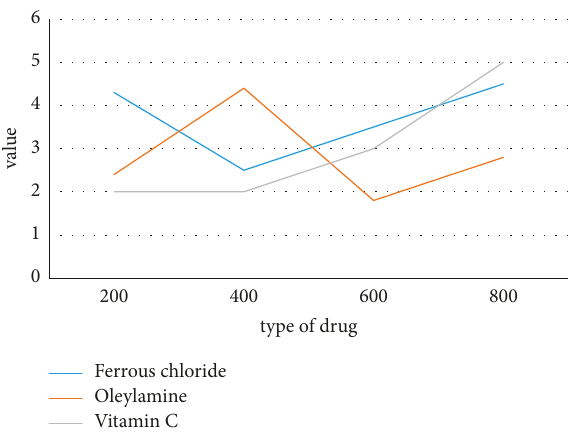
Figure 5: Optimum raw material